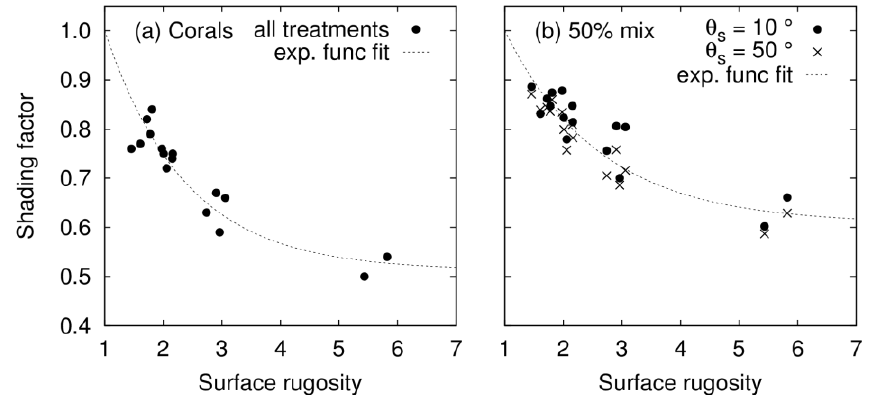
Figure 7. Median shading factor as a function of surface rugosity: ( a ) Over coral area only (Figure 4), and; ( b ) over coral area and surrounding substrate in a 50% areal mix (Figure 6) with data separated into solar zenith angles of 10 ◦ and 50 ◦ . Lines are of the form y = (1 − A ) × exp[ − S × ( x − 1)] + A and are the least squares best fit, giving ( a ) A = 0.51, S = 0.72; ( b ) A = 0.61, S = 0.61.